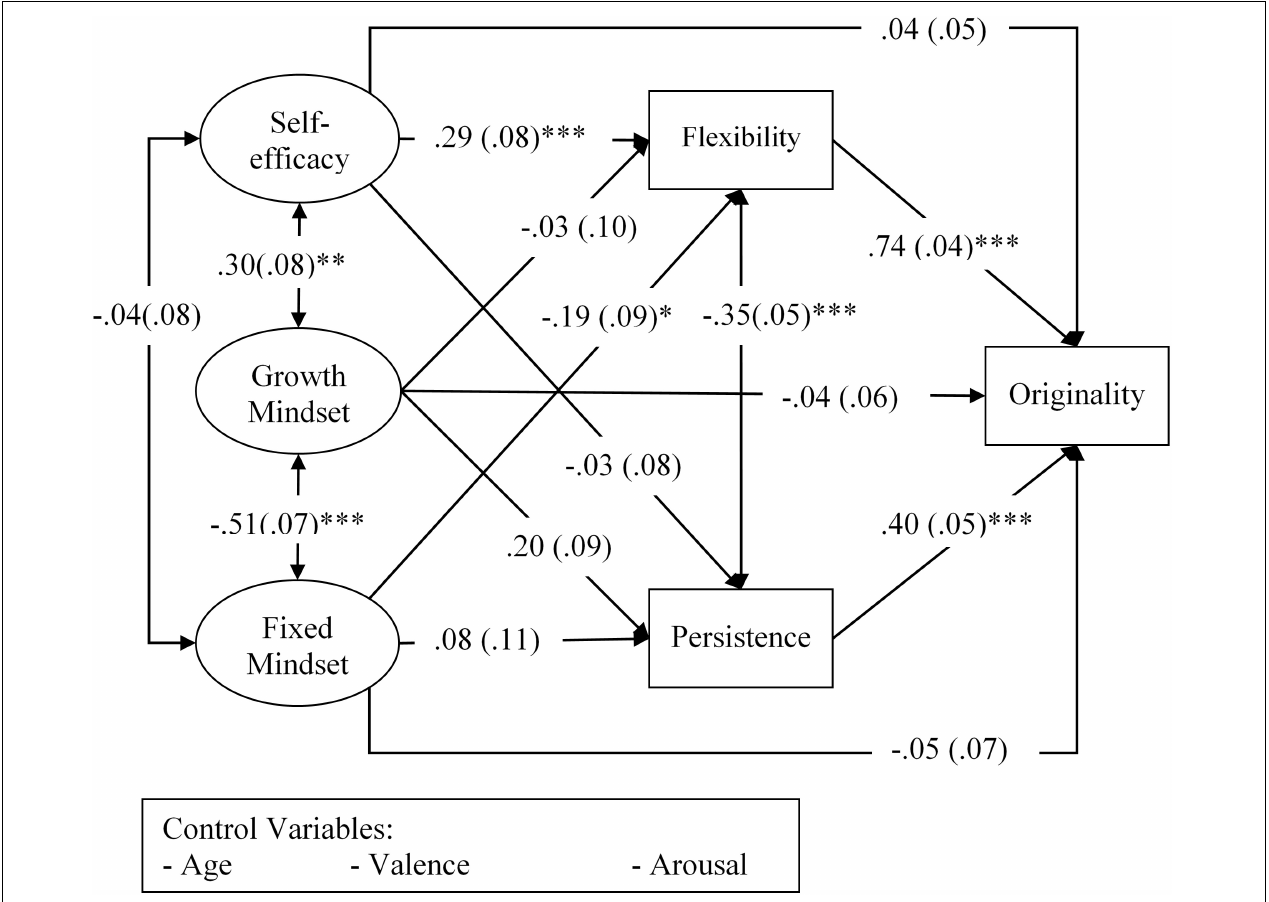
FIGURE 1 | The relationships between creativity as indicated by the originality score and, creative self-efficacy and creative mindsets via cognitive processing channels while controlling the effects of age, valence and arousal (Model 2). The values represent standardized path coefficients with standard errors in